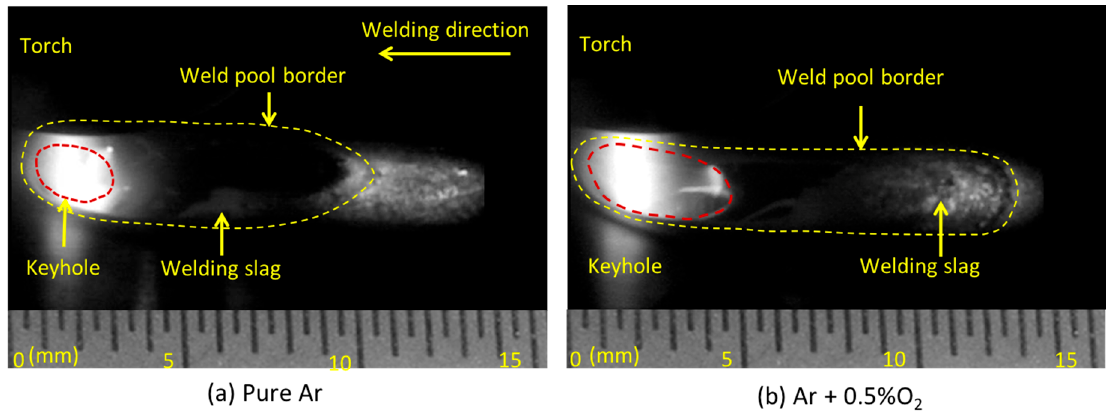
Figure 11. Weld pool surface appearance. ( a ) pure Ar, ( b ) Ar + 0.5% O 2 .